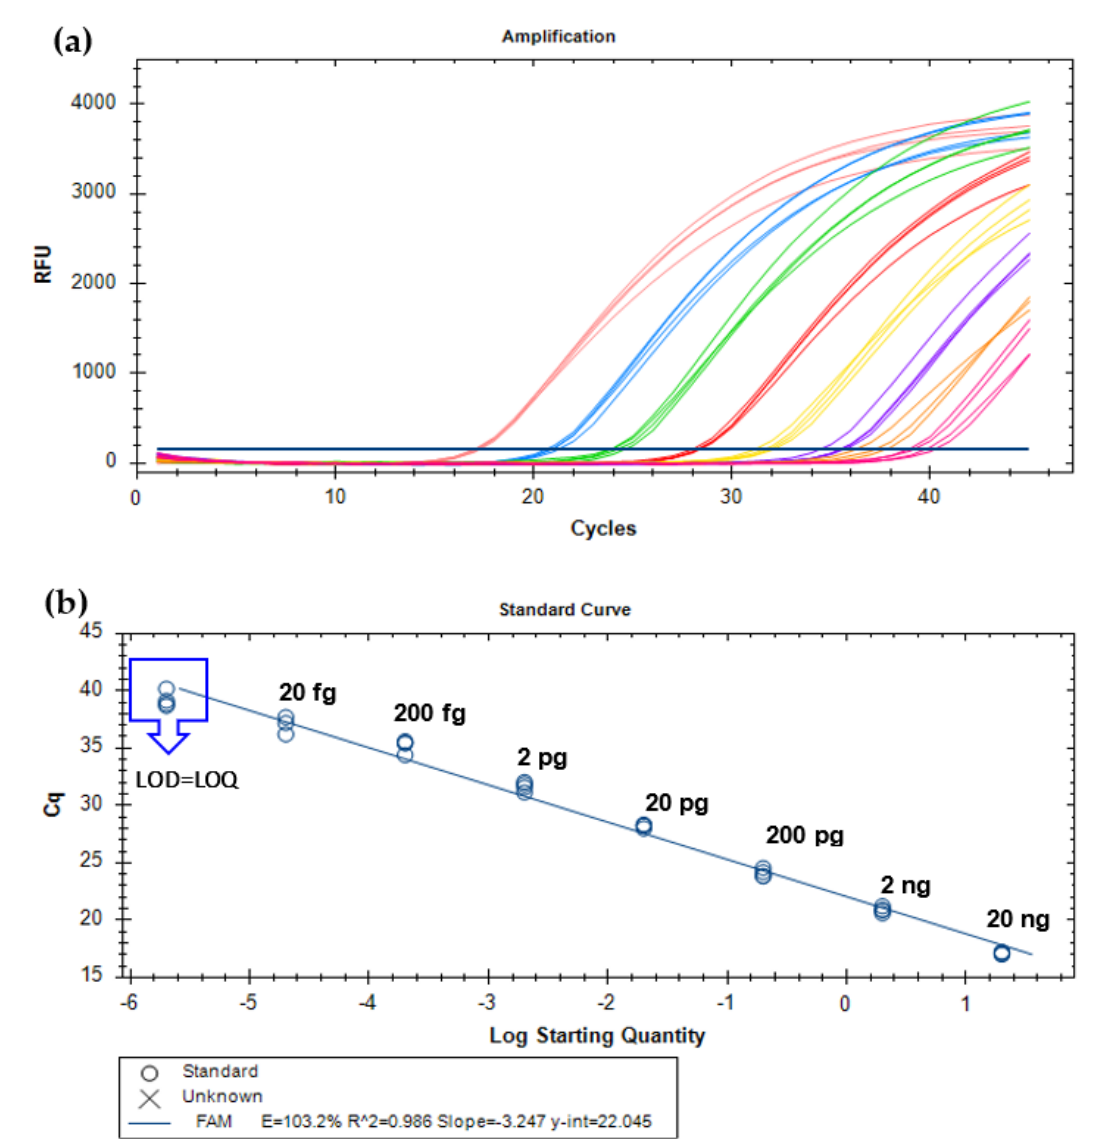
Figure 1. Amplification curves ( a ) and respective calibration curve ( b ) obtained by real-time PCR with TaqMan probe targeting the cytochrome b gene and using serially diluted (1/10) DNA extracts of T. molitor from 20 ng to 2 fg ( n = 4 replicates). Cq—cycle of quantification.